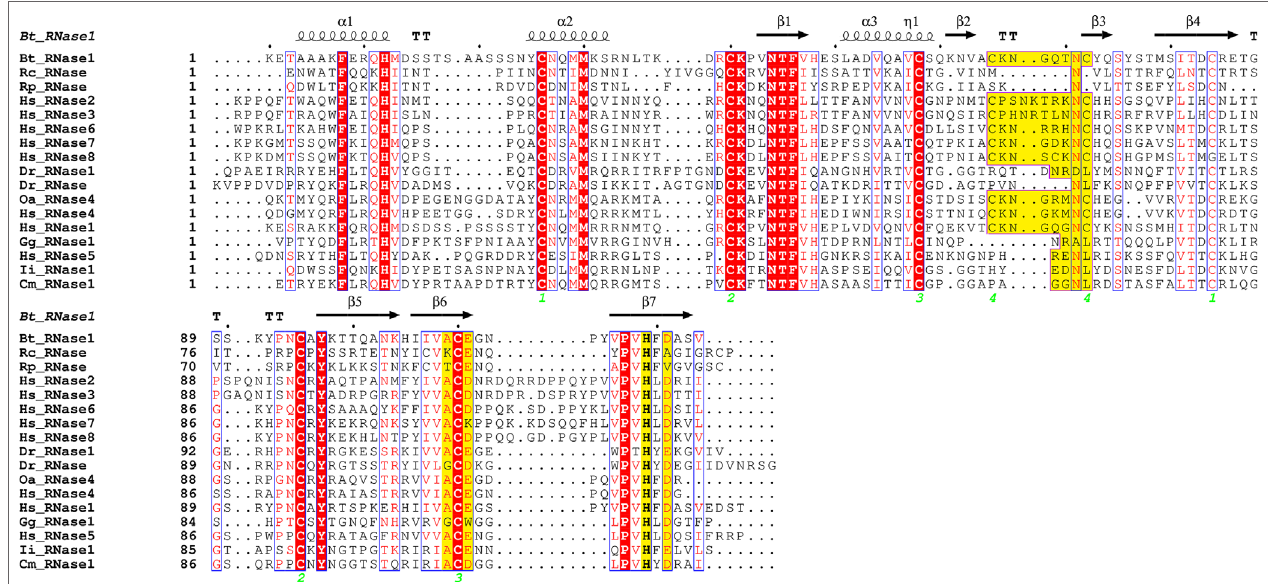
FIGURE 1 | Sequence alignment of the eight canonical human RNases together with the RNase A superfamily members analyzed by molecular dynamics (sequences correspond to mature proteins, without the signal peptide). Protein regions identified to participate in B2 site are highlighted in yellow: L4, spanning from b 2 to b 3, end of β 6 (residues 109 and 111) and one of the two catalytic histidines together with a close by residue at β 7 (residues 119 and 121). TT indicates the presence of a β -turn . Dots label every 10 residues of the reference protein used (Bt-RNase 1, known as RNase A). The disulphide bonds are labeled with green numbers. Full species names are included in Table S1 . Labels are as follows: red box with white character for strict identity; red character for similarity within a group; and character with blue frame for similarity across groups. The alignment was performed using Clustal Omega (Sievers and Higgins, 2018), and the picture was drawn using ESPript (Robert and Gouet,